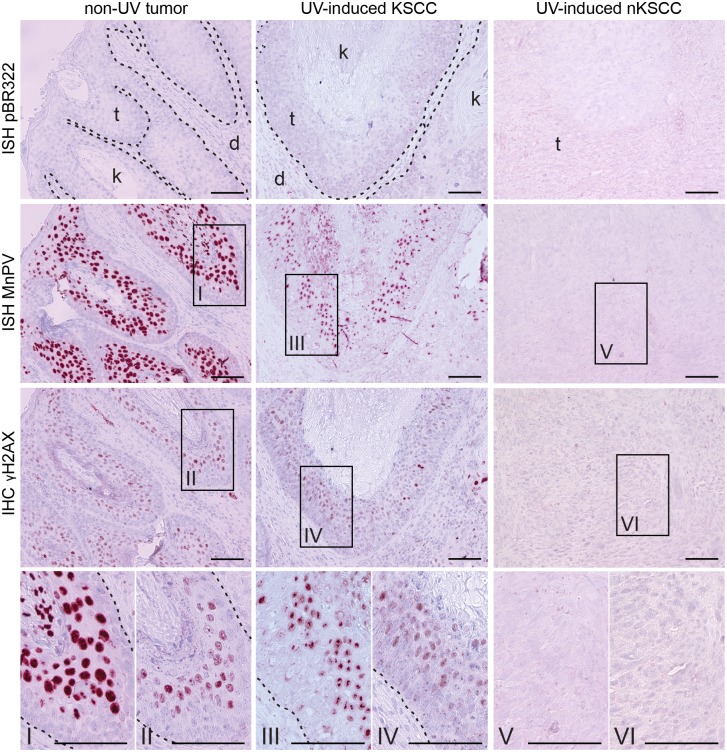
Induction of γH2AX foci by MnPV.Co-detection of γH2AX and MnPV DNA in consecutive tissue sections. Left panel: γH2AX staining of a non-UV tumor correlates with high viral load detected by ISH with a MnPV-specific probe (Viral load: 12065.07 ± 1119.24 copies/cell). Middle panel: the same concurrence can be detected in UV-induced KSCCs (Viral load: 26592.94 ± 1823.92 copies/cell). Right panel: UV-induced nKSCCs are negative in both stainings (Viral load: 0.98 ± 0.1 copies/cell; scale bars: 100 μm).